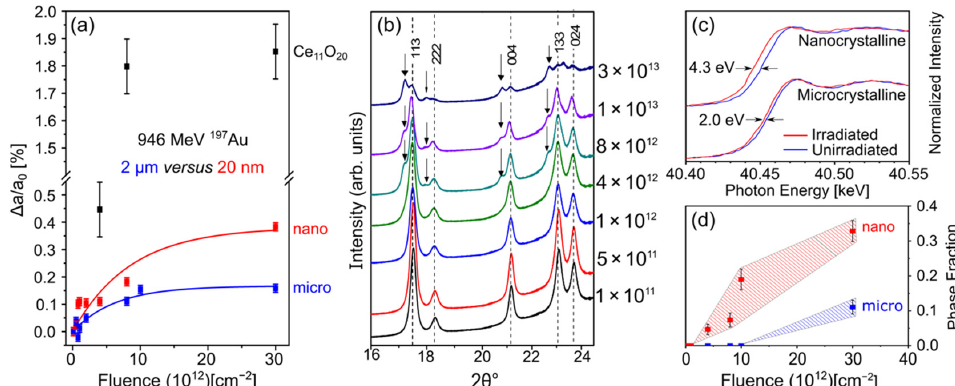
Figure 6. ( a ) Fluence-dependent change in unit cell parameter based on XRD pattern analysis for microcrystalline CeO 2 (blue, grain size = 2 μ m), nanocrystalline CeO 2 (red, grain size = 20 nm), and the Ce 11 O 20 phase produced in nanocrystalline samples ( black ), all relative to the unit cell parameter of unirradiated CeO 2 . ( b ) X-ray diffraction patterns of irradiated nanocrystalline CeO 2 as a function of fluence, displaying the emergence of new peaks corresponding to the Ce 11 O 20 phase, as indicated with arrows. ( c ) X-ray absorption spectra of the cerium K-edge in CeO 2 before irradiation (blue) and after irradiation to a fluence of 5 × 10 13 ions/cm 2 (red) in nanocrystalline ( top ) and microcrystalline ( bottom ) samples. ( d ) Phase fraction of Ce 11 O 20 relative to the fluorite phase as a function of ion fluence for microcrystalline (blue) and nanocrystalline (red) CeO 2 . Irradiation was performed with 946 MeV Au ions. These data were adapted from Cureton et al. [53] ( a , b , d ) and Tracy et al. [47] ( c ).